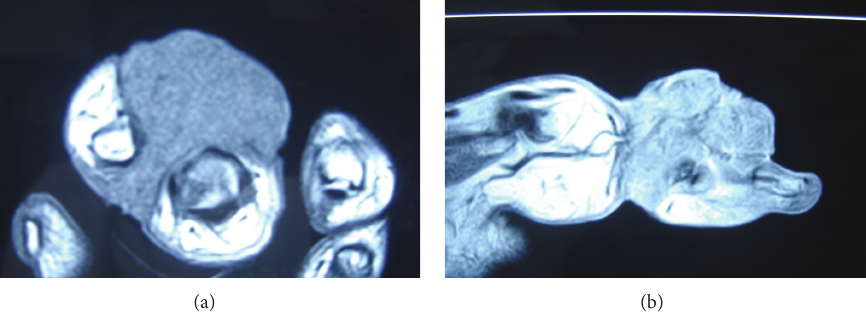
Figure2:PreoperativeMRIofthelefthandshowsaninfiltratingsoft-tissuemasswithsuspicionofmalignancy(histiocytomaorfibrosarcoma) without osseous